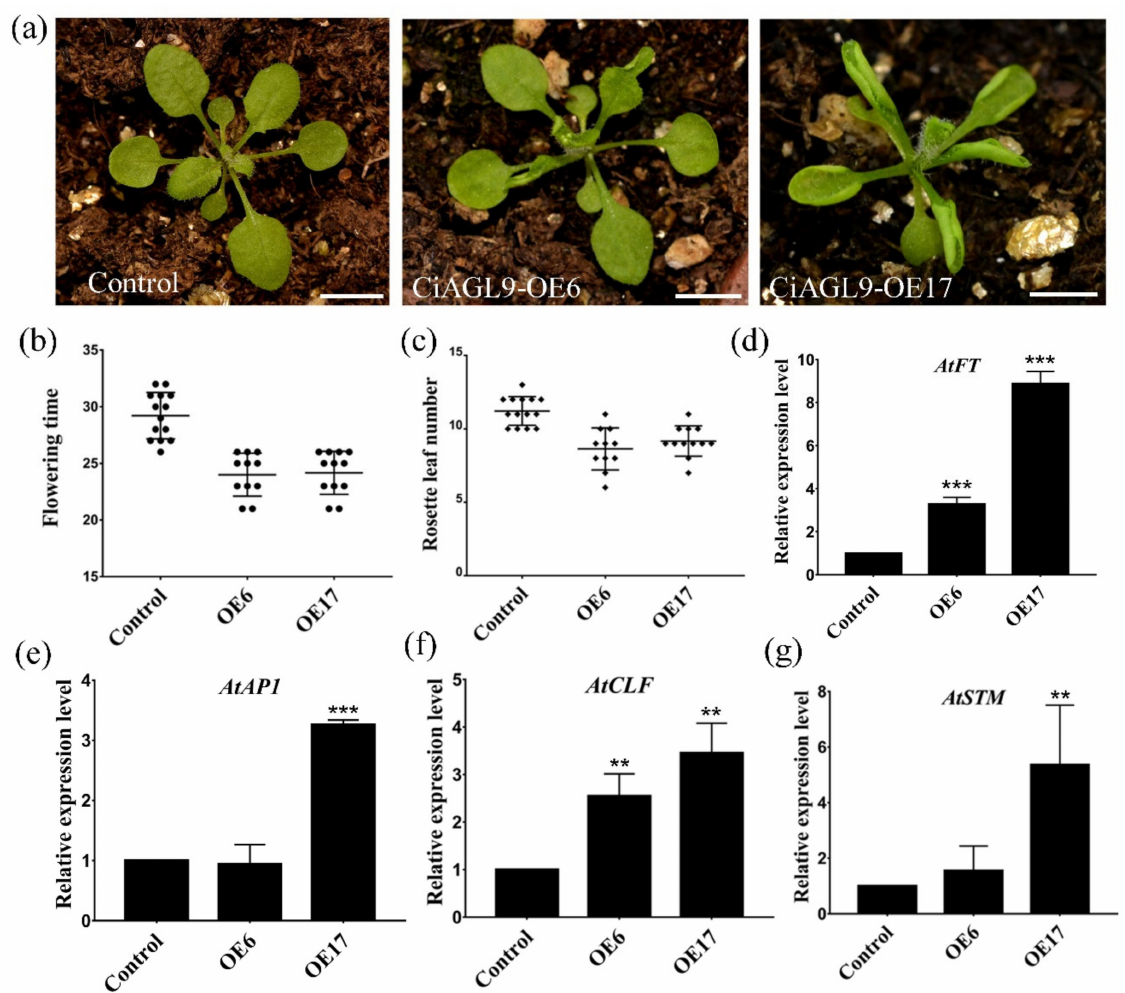
Figure 7. Ectopic expression of CiAGL9 causes slightly early flowering and leaf curling in transgenic Arabidopsis . ( a ) The phenotype of CiAGL9 transgenic Arabidopsis . Two transgenic lines (CiAGL9-OE6 and CiAGL9-OE17) were selected as representatives of 17 transgenic lines for evaluating CiAGL9 function. Scale bar = 0.5 cm. ( b ) Statistical analysis of flowering days of the transgenic Arabidopsis and the control. ( c ) Statistical analysis of rosette leaves number of the transgenic Arabidopsis and the control at flowering stage. ( d , e ) qRT-PCR analysis of Arabidopsis flowering-related genes ( AtFT and AtAP1 ). ( f , g ) qRT-PCR analysis of Arabidopsis leaf development related genes ( CLF and STM ). Statistically significant was marked with asterisk(s) (** p < 0.01, and *** p < 0.001, Student’s t